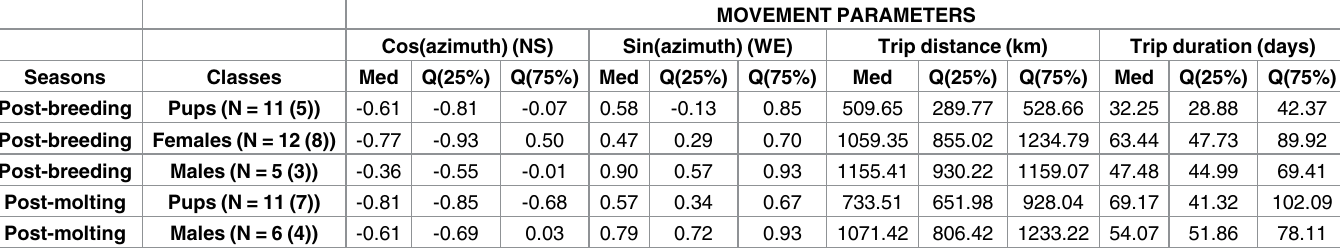
Table 1. Movement parameters for hooded seal adult males, adult females and pups during the post-breeding and the post-molting seasons. Med. = median,and Q (25%) and Q (75%) = the 25% and 75% quantiles,respectively. The numberof trips per age/sex class and season is detailed in paren- thesis. These trips were conducted by 3 males, 9 females and 6 pups in the post-breeding periodand by 2 males and 5 pups in the post-molting period. The second number in parenthesis representsthe number of